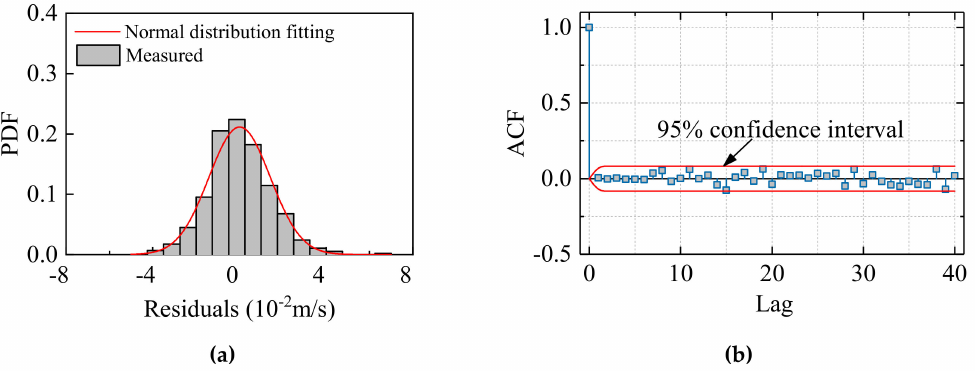
Figure 7. Analysis of residual components. ( a ) PDF; ( b )